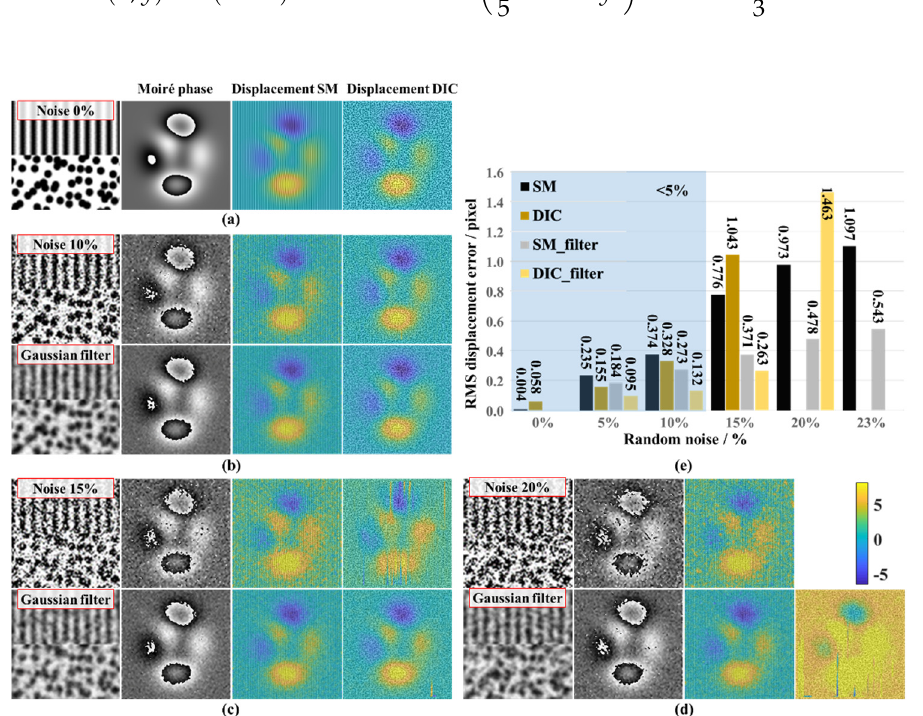
Figure 6. The RMS displacement error versus random noise obtained by SM and DIC. ( a ) Noise-free ( b ) Noise 10%, ( c ) Noise 15%, ( d ) Noise 20%, ( e ) RMS displacement error under different noise levels.